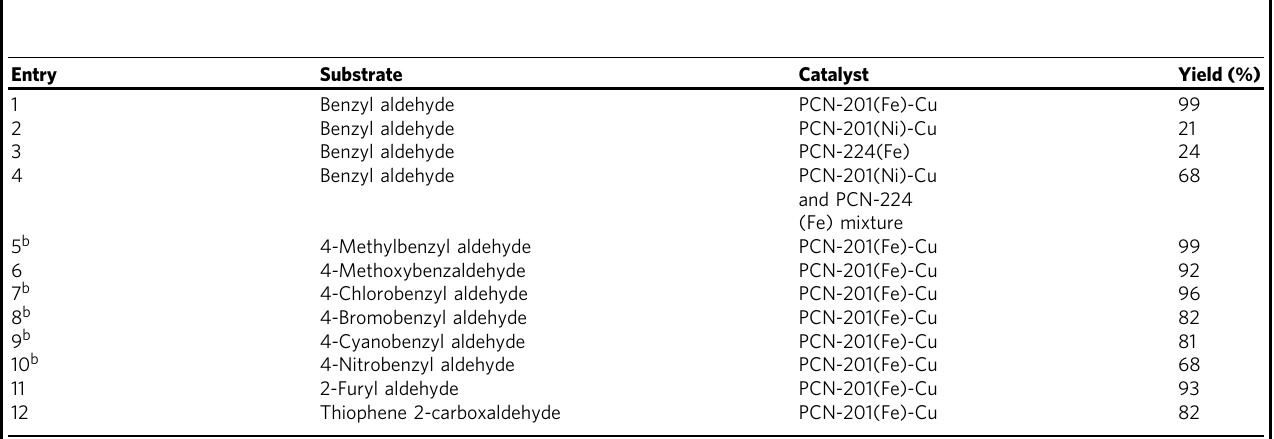
Table 1 Catalytic performance of PCN-201(Fe)-Cu in the three-component Strecker reaction